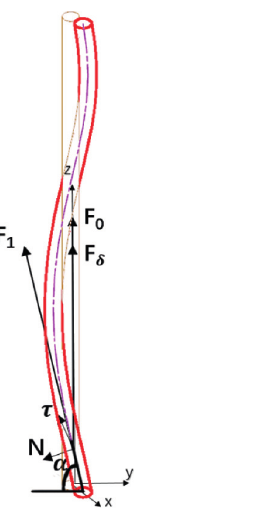
Figure 9: Steel cord stress decomposition.